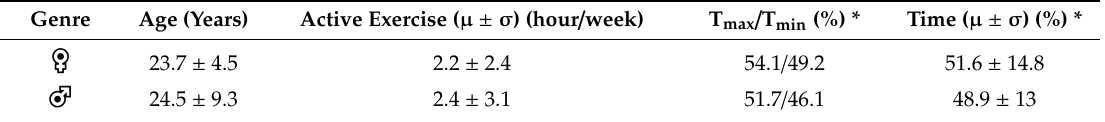
Table 7. Summary of the information collected from the experiments.